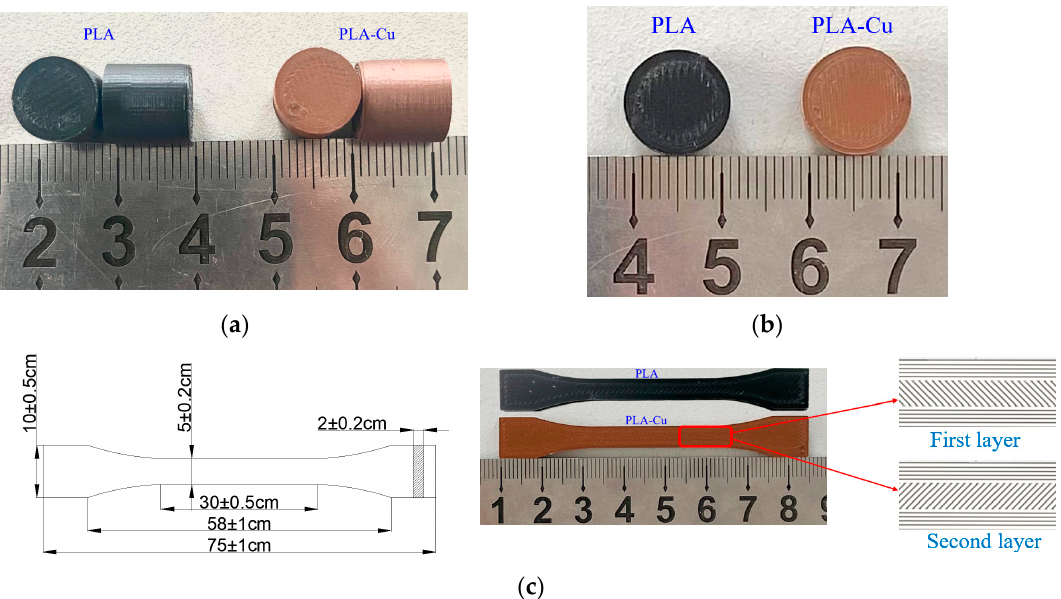
Figure 1. Specimen size and physical drawing. ( a ) Quasi-static compression; ( b ) dynamic compression; ( c ) quasi-static stretching.